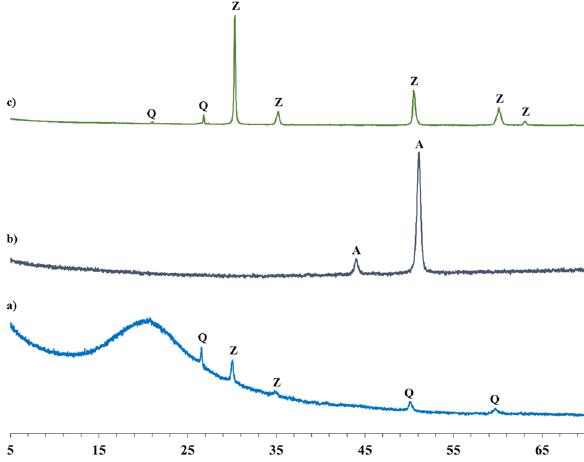
Figure 1: XRPD of a – composite ( Q – quartz, Z – zirconia ) , b – alloy ( A – Ni – Cr – Mo alloy ) and c – zirconium ( Q – quartz, Z – zirconia ) .